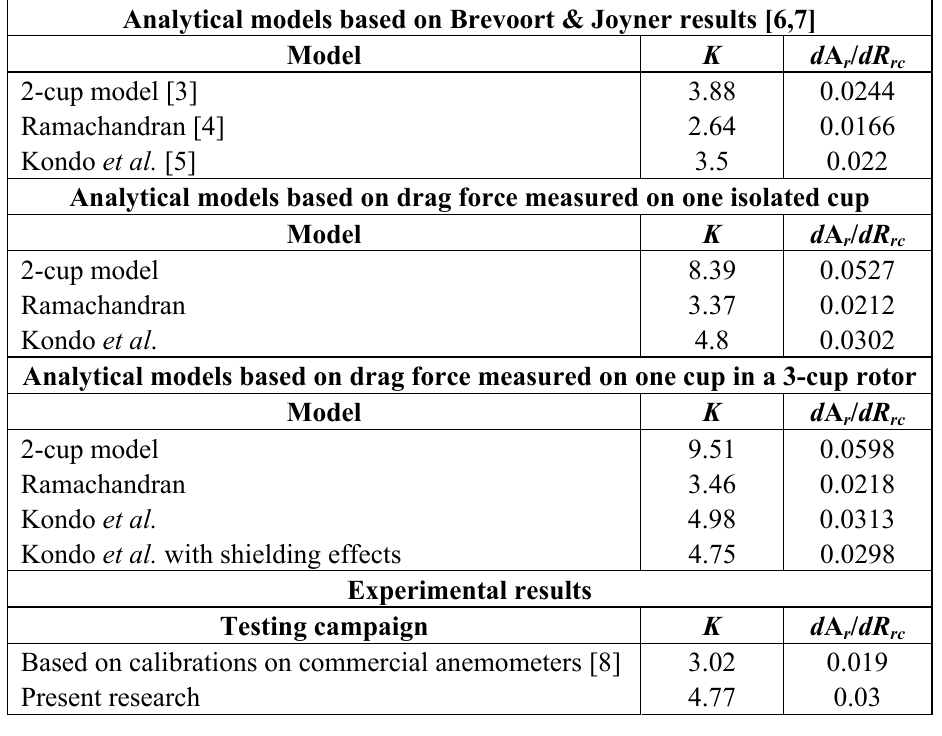
Figure 14. Standard deviation of the normal force on the cup divided by the mean value of / N , as a function of the wind angle with respect to the cup, α , in the two cases this force, σ N tested, cup isolated and cup in a 3-cup